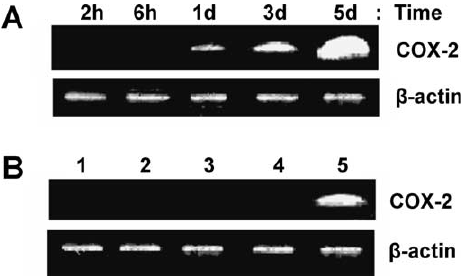
FIG. 2. RT-PCR results of COX-2 mRNA expression in rat air- pouch granulation tissue. b -Actin was used as internal control. (A) Temporal changes in COX-2 expression from day 1 to day 5. (B) Inhibition of COX-2 expression in day 3 granulation tissue after treatment with 3 mg/kg and 30 mg/kg of celecoxib (lanes 1 and 2) and 0.3 mg/kg and 10 mg/kg of dexamethasone (lanes 3 and 4). Lane 5 shows COX-2 expression in untreated day 3 granulation